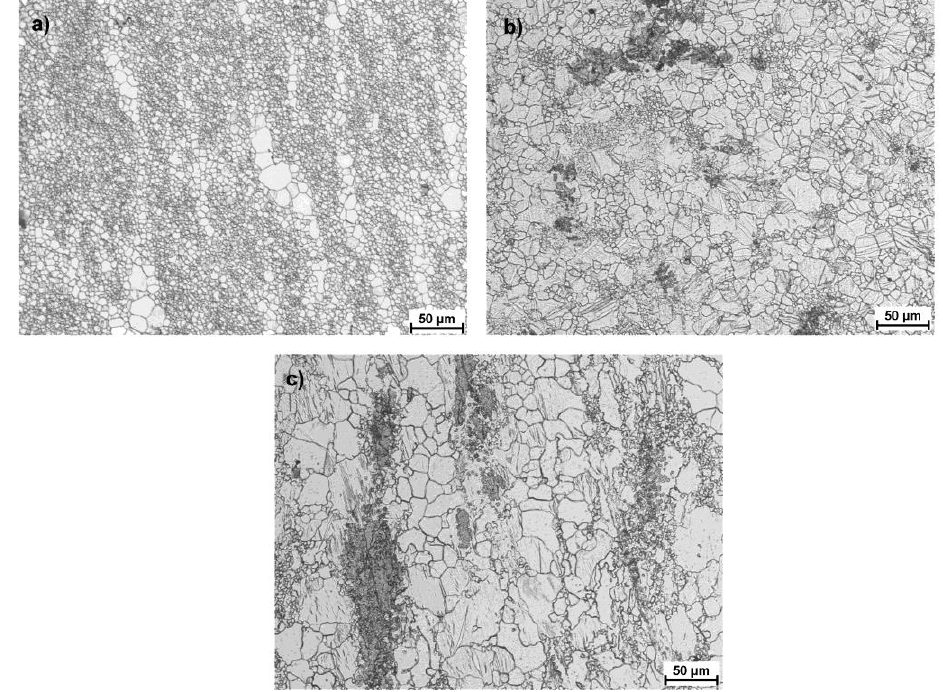
Figure 12. Microstructure obtained for finished bars with the diameter of 15 mm rolled according to Variant III, defined for ( a ) surface zone, ( b ) middle zone, ( c ) central zone. Table 4. Grain sizes for the analyzed variants of the RSR process.